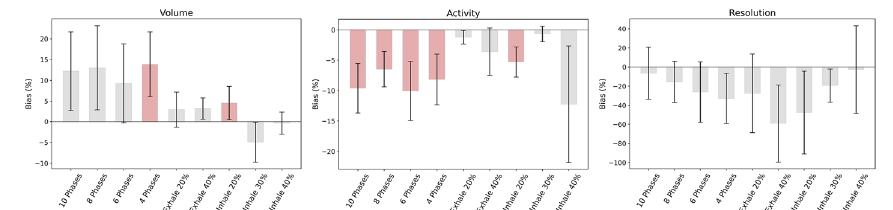
Fig. 15 Bland–Altman and WSRT results for the comparison of Exhale 30% with respect to all protocols. The columns represent the average value for the relative deviation in percentage between paired series of data. The error bars represent the interval of confidence. When the interval involves the zero, series are considered comparable. The protocols not comparable under WSRT are shown in